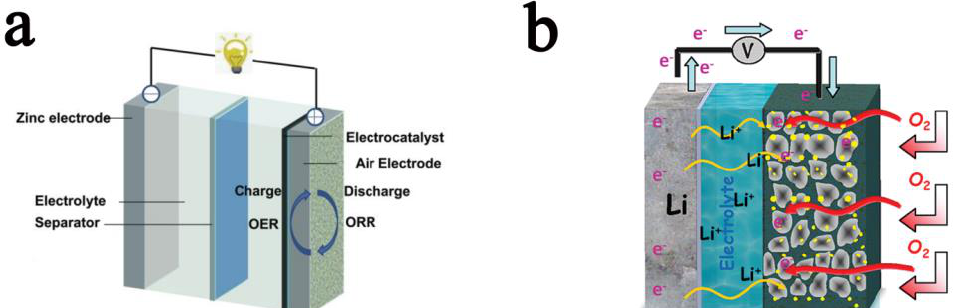
Figure 3. ( a ) Schematic illustration of Zn–air battery. Adapted with permission from ref. [78]. Copyright 2020, American Chemical Society. ( b ) Schematic illustration of Li–air battery. Adapted with permission from ref. [79]. Copyright 2010, American Chemical Society.